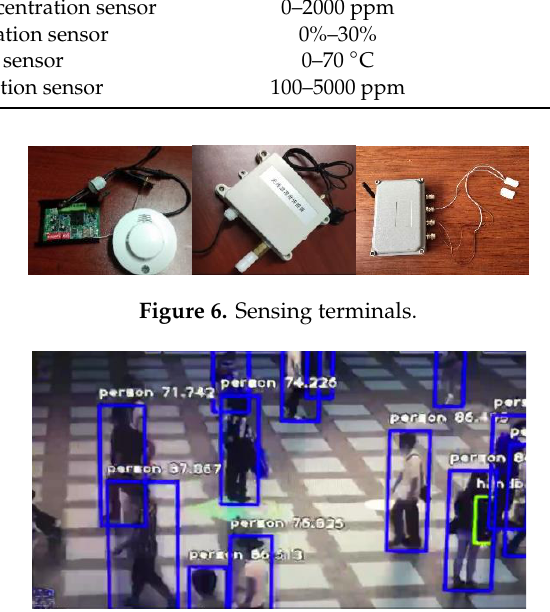
Figure 7. Automatic determination of the number of people using image-recognition technology. Table 1. Sensor parameters.